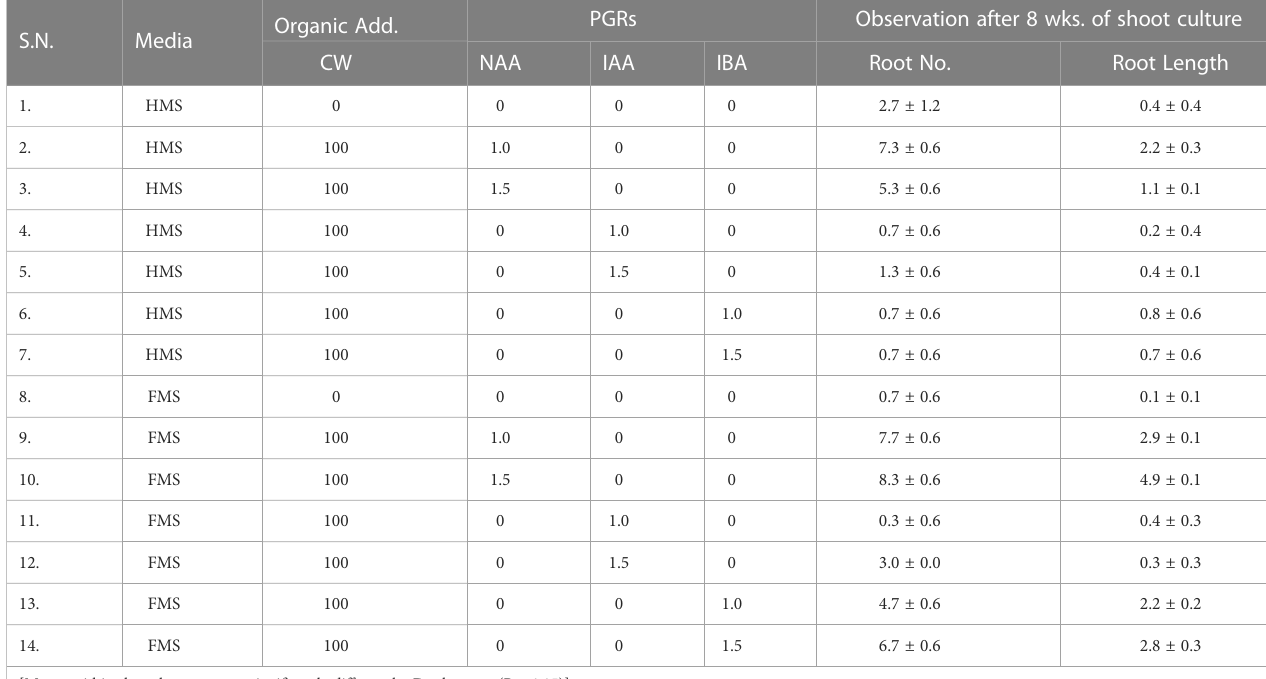
TABLE 3 In-vitro root development of D. transparens in various media supplements.